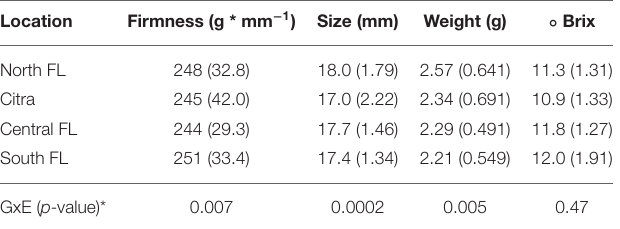
TABLE 2 | Mean and standard deviation (in parenthesis) of four fruit quality traits were evaluated in advanced stages of the blueberry breeding program at four Florida